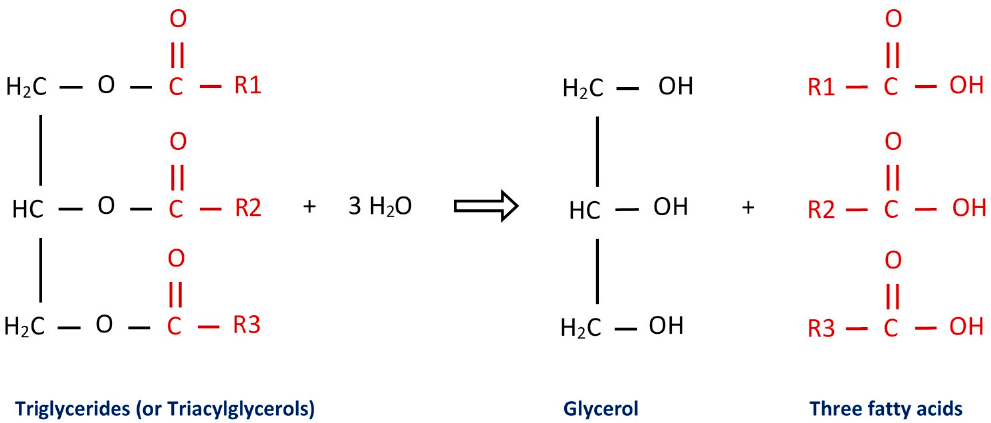
Figure 6. The mechanism of hydrolysis of triacylglycerols.